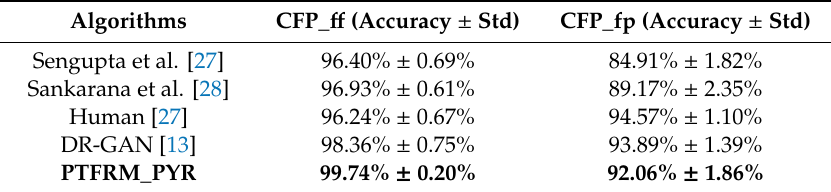
Table 3. Accuracy of related algorithms on the CFP test set.